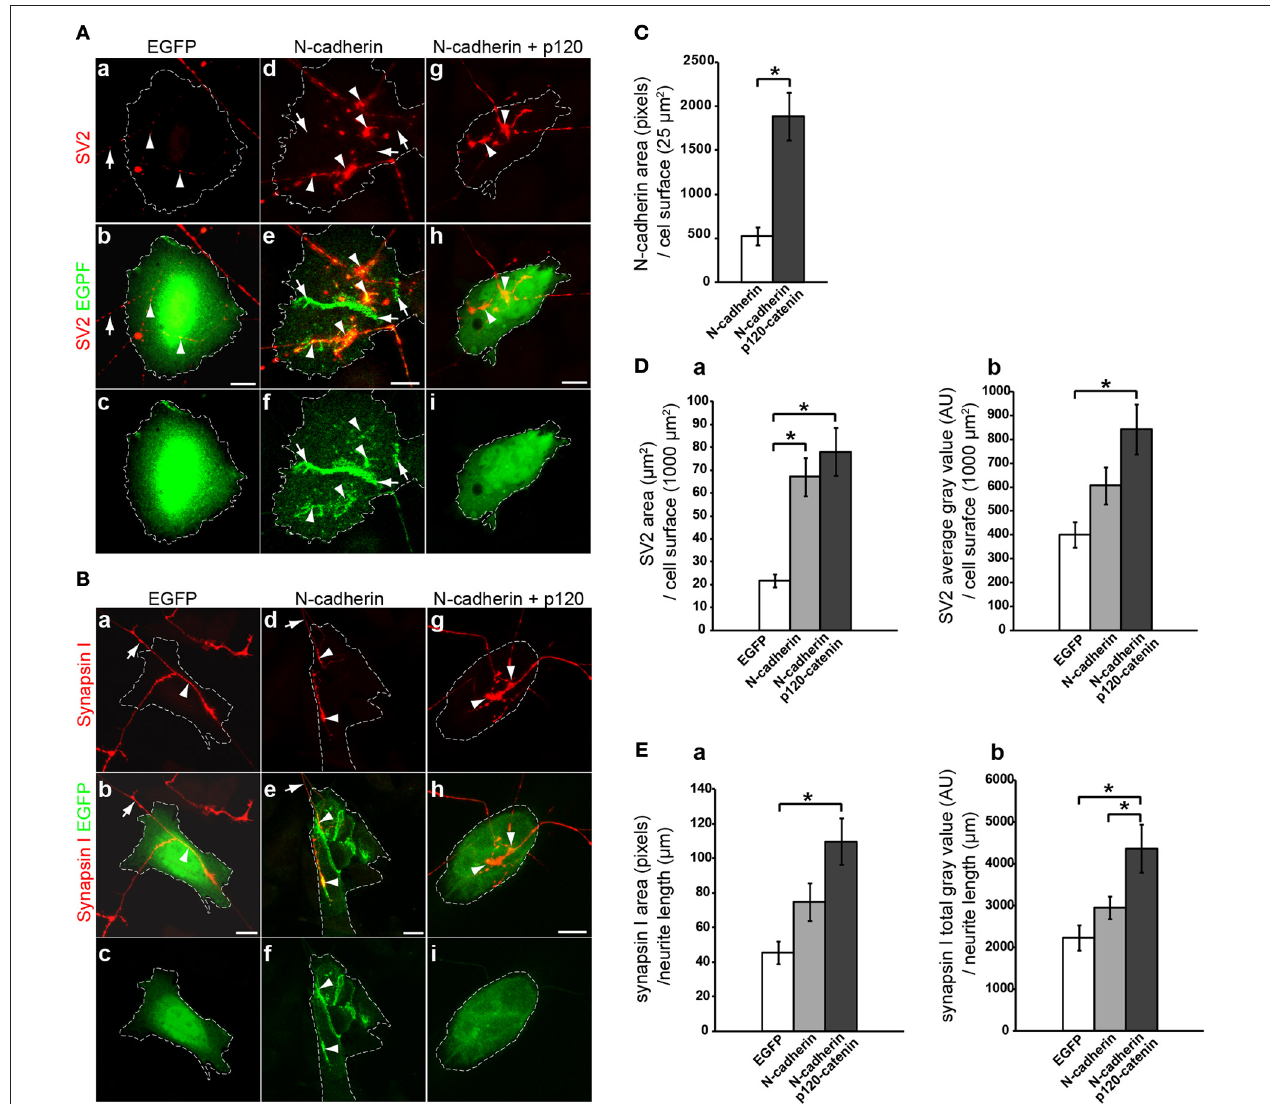
FIGURE 2 | Analysis of N-cadherin-mediated effect on synaptic vesicle accumulation in cholinergic neurons. CHO cells transfected with EGFP, N-cadherin-EGFP, or N-cadherin-EGFP and p120-catenin-EGFPwere plated on 5 days old brainstem cholinergic nuclei explants and cocultured for 2 days. Tissue cultures were fixed and immunostained with SV2 (A) or synapsin I (B) antibodies. (A,B) Confocal images of CHO cells transfected with EGFP (a,b,c) , N-cadherin-EGFP (d,e,f) , or N-cadherin-EGFP and p120-catenin-EGFP (g,h,i) . Panels (a) , (d) , and (g) , show SV2 or synapsin I immunostaining (red); panels (b) , (e) , and (h) , show merged images with EGFP fluorescence (green); and panel (c) , (f) , and (i) , show EGFP fluorescence alone. A white dashed line delineates the contour of the transfected CHO cell in each panel. (C) N-cadherin expression levels in CHO cells transfected with N-cadherin or cotransfected with N-cadherin and p120-catenin were measured as pixels of